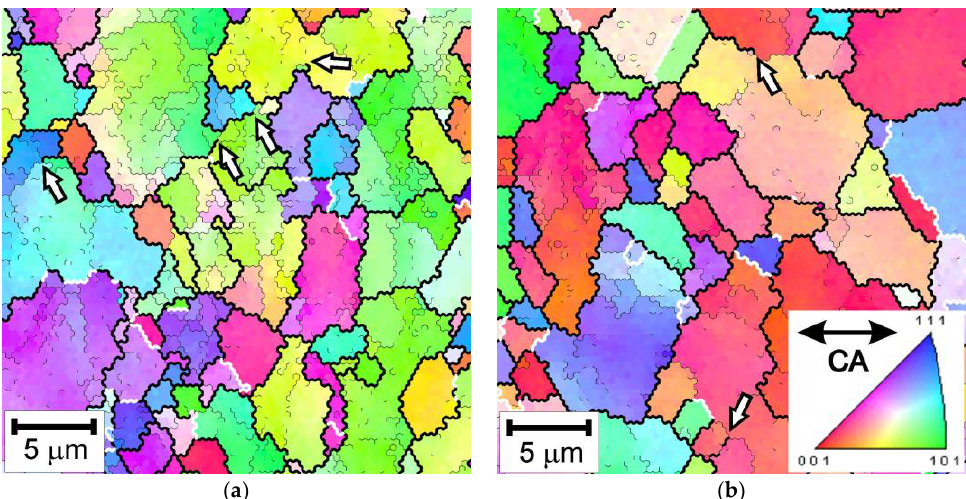
Figure 8. The representative deformation microstructures evolved in a high-Mn steel during hot compression at a temperature of 1073 K and a strain rate of 10 −2 s −1 ( a ) or 10 −3 s −1 ( b ). The colors indicate the orientation along the compression axis (CA). The high-angle boundaries, low-angle sub-boundaries, and twin boundaries are shown by the thick black lines, thin black lines, and white lines, respectively.